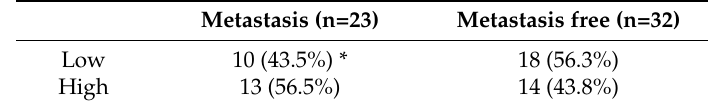
Table 4. Number of uveal melanoma (with and without metastasis) with low and high ABCB5.